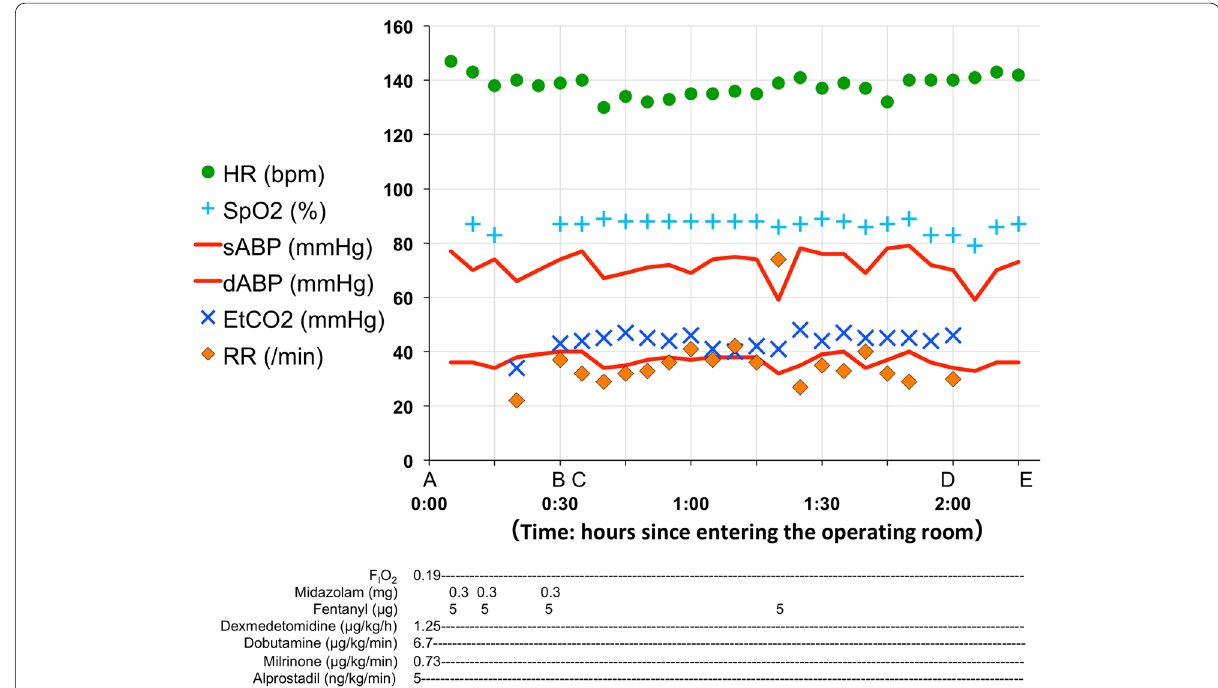
Fig. 1 Hemodynamic changes in the patient during cardiac catheterization upon A entry into the operating room, B initiation of examination/ vascular puncture, C insertion of the 5-Fr sheath/arterial blood gas analysis, D completion of the examination, and E exit from the operating room. sABP, systolic arterial blood pressure; dABP, diastolic arterial blood